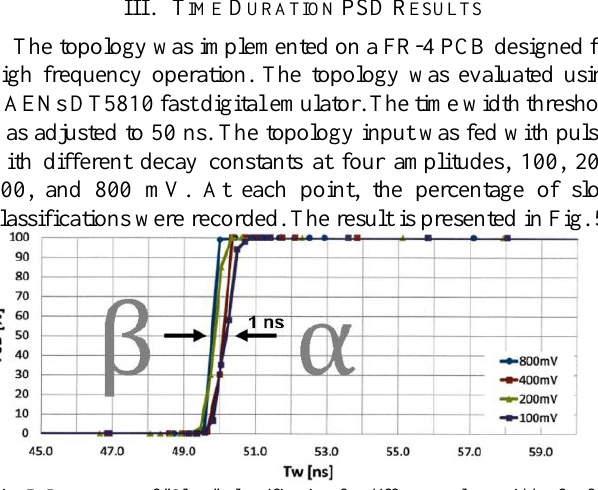
Fig. 5. Percentage of "Slow" classification for different pulses widths for four amplitudes, classification width threshold is set to 50